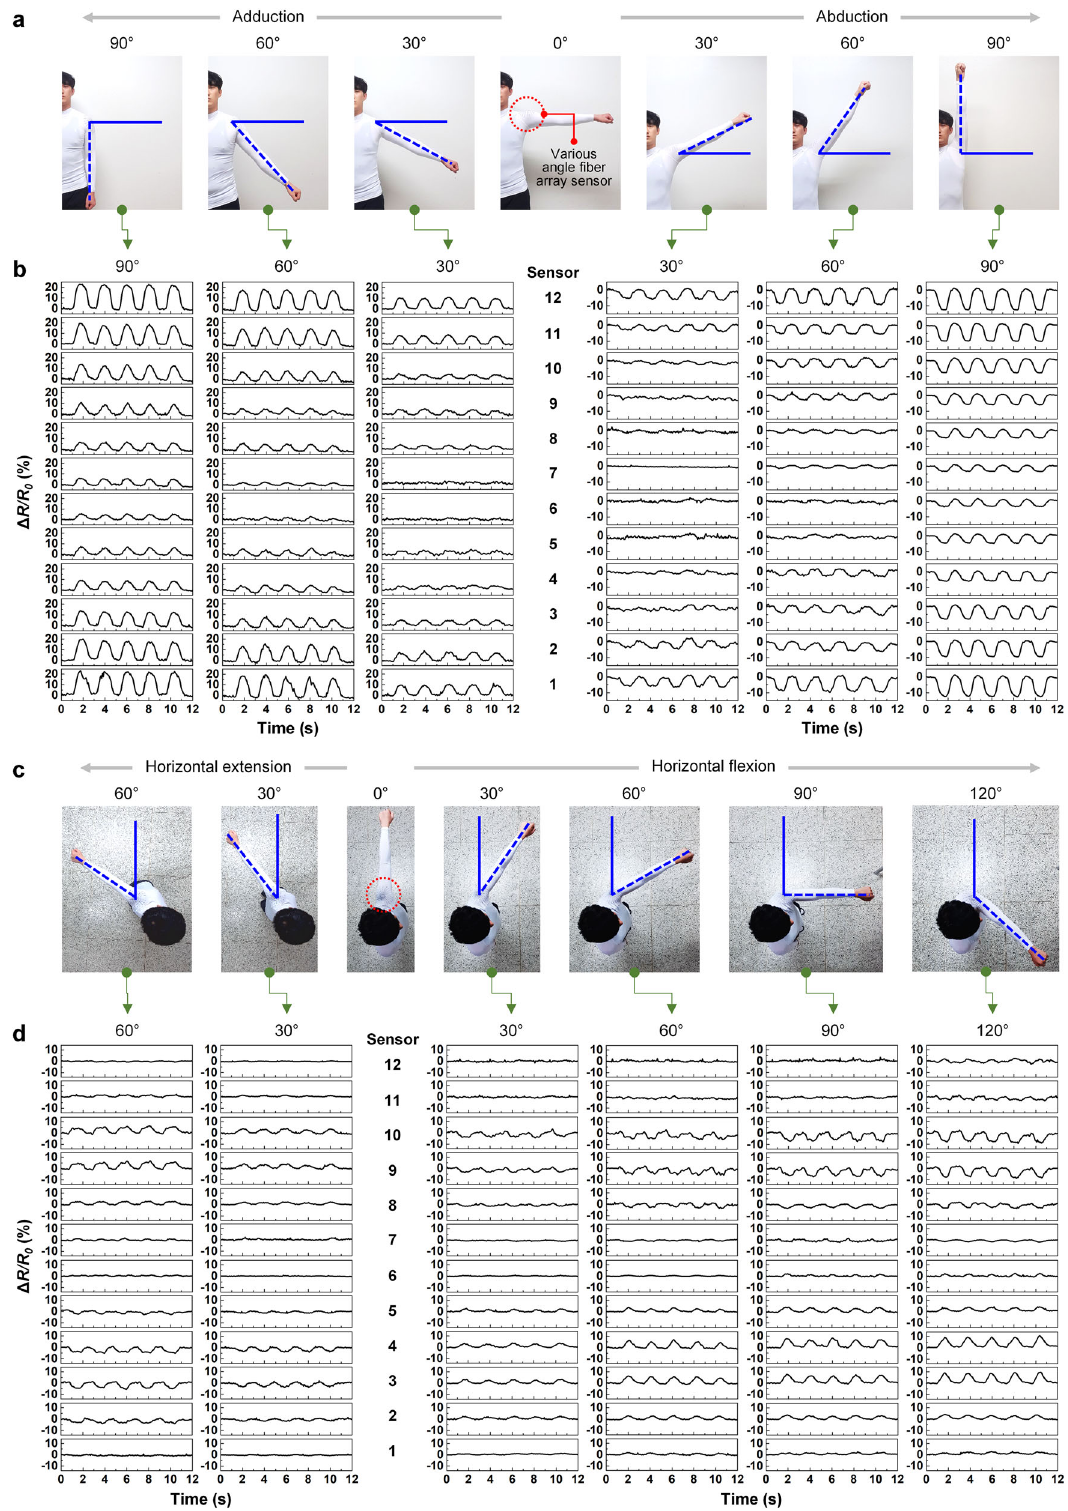
Fig. 4 Monitoring shoulder adduction, abduction, horizontal extension, and horizontal fl exion. a Adduction/abduction and c horizontal extension/horizontal fl exion of the left shoulder as demonstrated by a volunteer wearing a fi ber arrayed fabric sensor. Main electrical signal characteristics measured during b adduction and abduction at 30, 60, and 90° angles, and d horizontal extension at 30 and 60° angles and horizontal fl exion at 30, 60, 90, and 120° angles. I, M. Son, consent to the use of my picture in connection with the